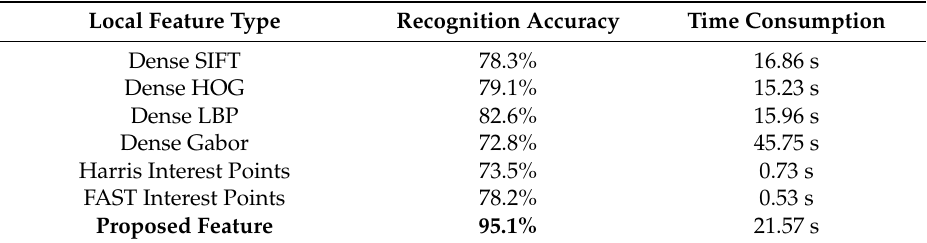
Table 3. Comparison and analysis of local feature description